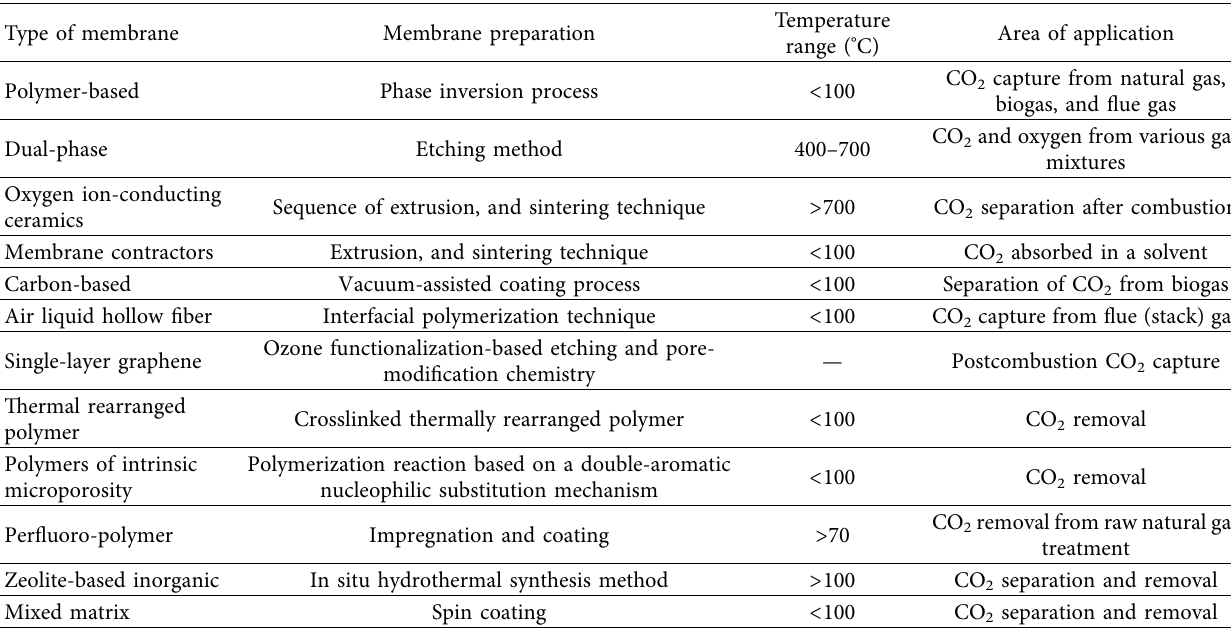
Table 1: CO 2 capture